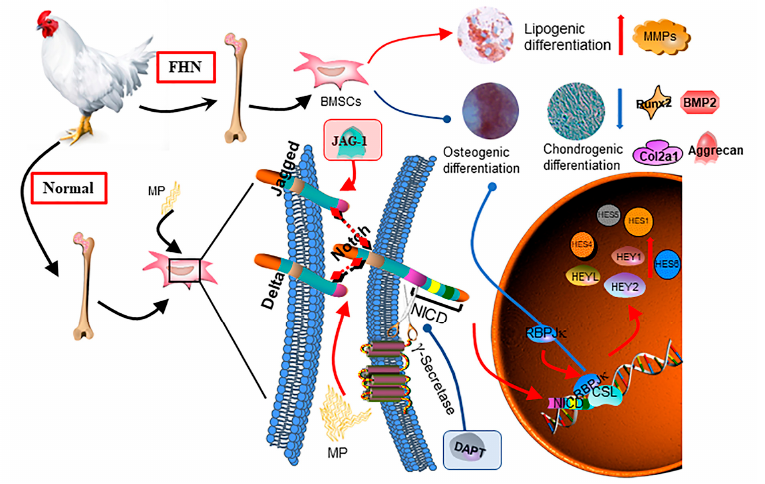
Figure 6. Schematic representation of the regulation of osteogenesis and chondrogenesis metabolism by Notch-RBPJ in BMSCs.